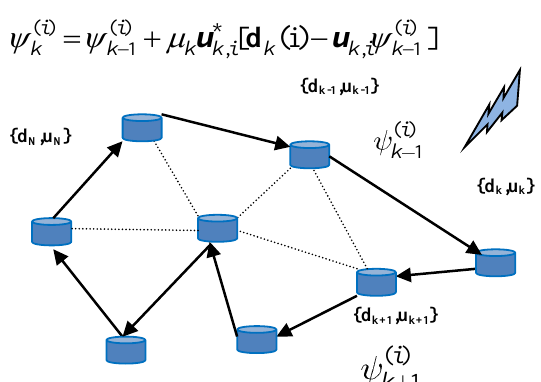
Figure 1. Structure of incremental LMS adaptive